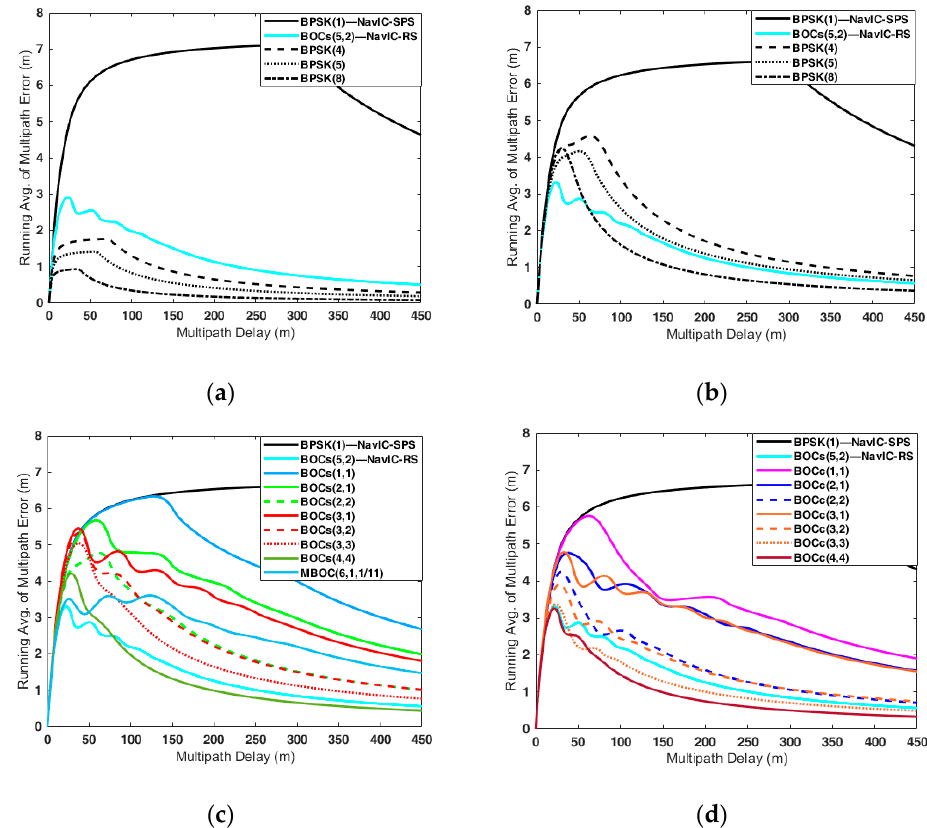
Figure 6. Running average of the multipath error envelope of the candidates in the S-band: ( a ) 𝐵 (cid:3045) = ∞ ; ( b – d ) 𝐵 (cid:3045) = 16.5 MHz. Table 9. Running average ( RA) of the multipath error envelope (MPEE) of the candidates in the S- band.